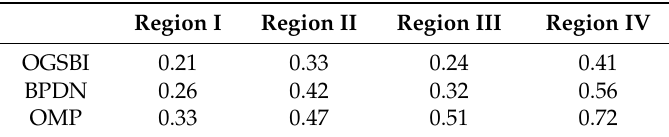
Figure 9. Grayscale histogram comparison of the input 2-D image and the orthographic projection reconstructed images by the three sparse recovery methods. Table 2. Relative error of cross-track reconstruction.